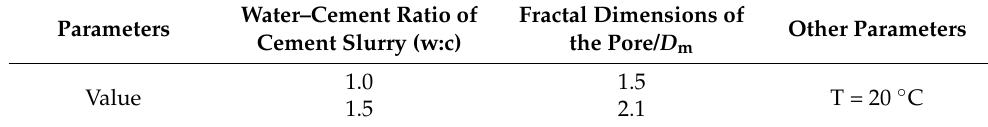
Table 1. Selection of model parameters.